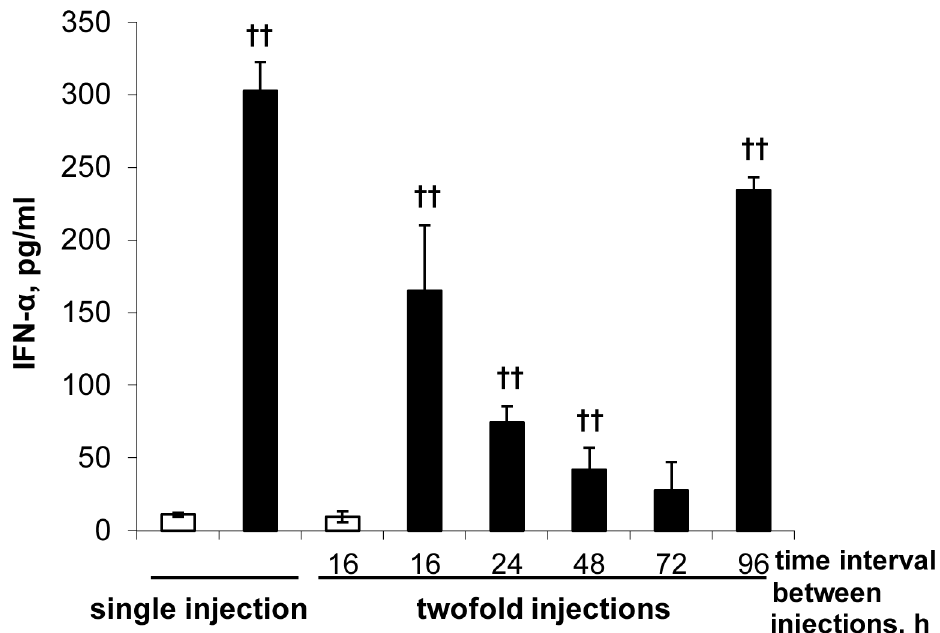
Fig 1. Refractory state for interferon induction follows a single injection of isRNA in mice. C57BL/6 mice were intravenously injected once or twice with 2X3-DOPE (white bars) or with isRNA/2X3-DOPE (black bars). The time intervals between the injections varied from 16 to 96 h. Serum IFN- α levels were measured by ELISA 6 h after the last injection. The data represent mean ± standard deviation (SD) calculated from measurements from at least three mice. Statistically significant differences between experimental groups and the 2X3-DOPE-treated group (Mock) are indicated by crosses ( †† , P < 0.01); Mann-Whitney U test.